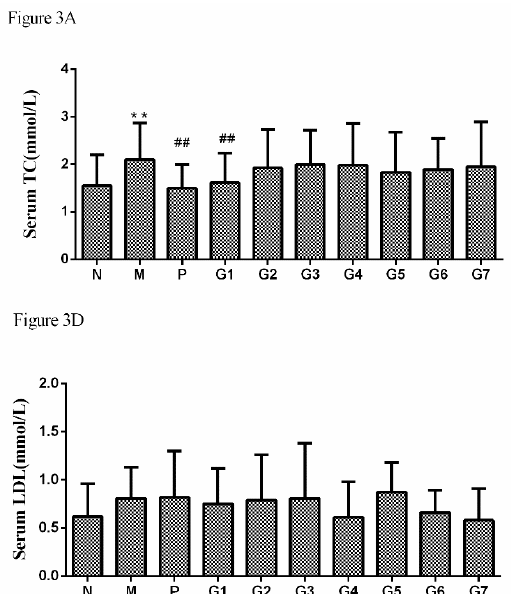
Figure 3. The effect of glycyrrhizic acid (GA) on lipid profile, including Serum TC (A), and Serum LDL (D). N: normal group, M: model group, P: silybin positive group, G1:18 α -GA:18 β -GA = 10:0, G2:18 α -GA:18 β -GA = 8:2, G3:18 α -GA:18 β -GA = 6:4, G4:18 α -GA:18 β -GA = 5:5, G5:18 α -GA:18 β -GA = 4:6, G6:18 α -GA:18 β -GA = 2:8, G7:18 α -GA:18 β -GA = 0:10. The values were expressed as mean ± SD ( n = 8). ** p < 0.01 vs. normal group, ## p < 0.01 vs. model group. Reference Huo, X.; Yang, S.; Sun, X.; Meng, X.; Zhao, Y. Protective Effect of Glycyrrhizic Acid on Alcoholic Liver Injury in